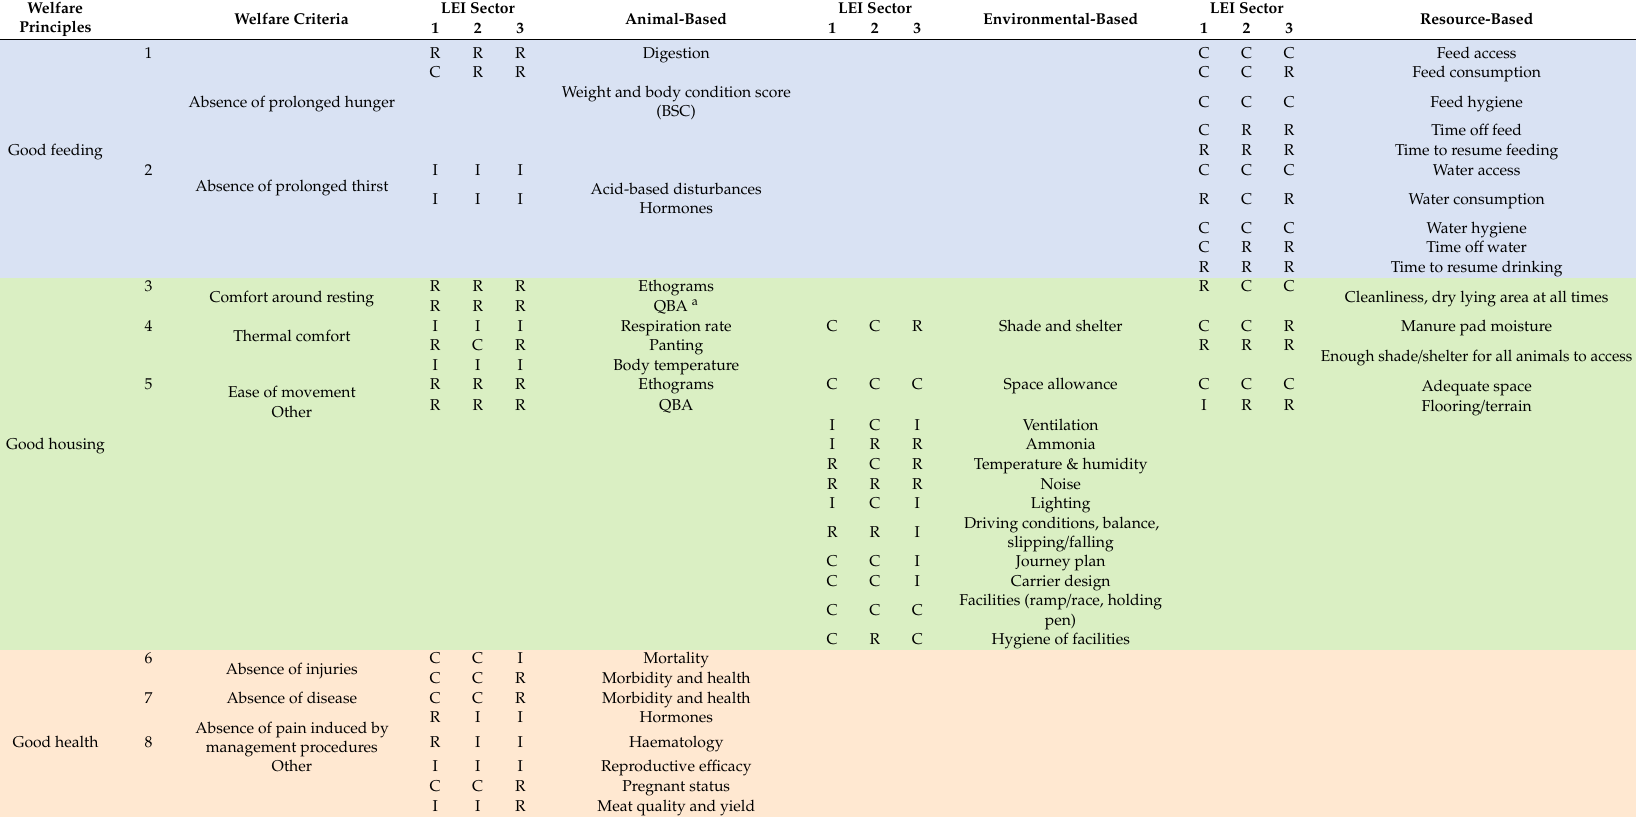
Table 3. Mapping of animal welfare measures onto the European Union’s Welfare Quality ® framework, per sector of the livestock export supply chain (1 = Australian farm, pre-export feedlots and land transport, 2 = Australian Standards for the Export of Livestock (ASEL) (on-board the ship / plane reports), 3 = Exporter Supply Chain Assurance System (ESCAS) (destination feedlot and abattoir). Measures are identified as (C) currently used as part of the life export industry (LEI) in some form, (R) relevant to the LEI, (I) largely irrelevant to the LEI sector due to impracticality or lack of opportunity. Colours are cross-referenced to Table